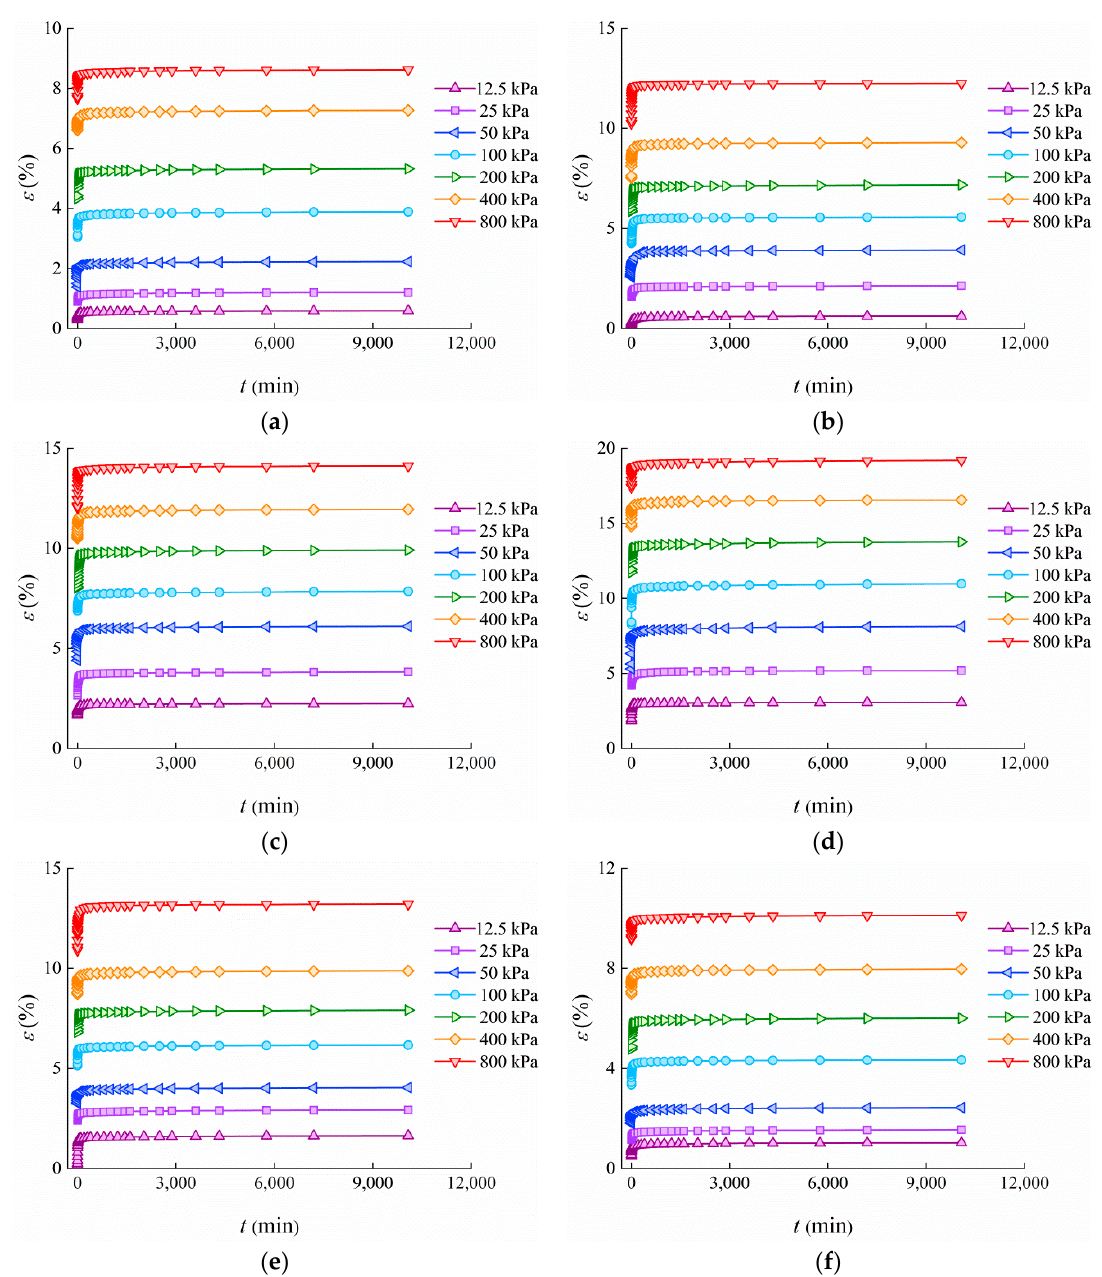
Figure 3. ε – t curves: ( a ) TJ, ω a = 8.33%; ( b ) TJ, ω a = 14.45%; ( c ) TJ, ω a = 19.56%; ( d ) TJ, ω a = 30.02%; ( e